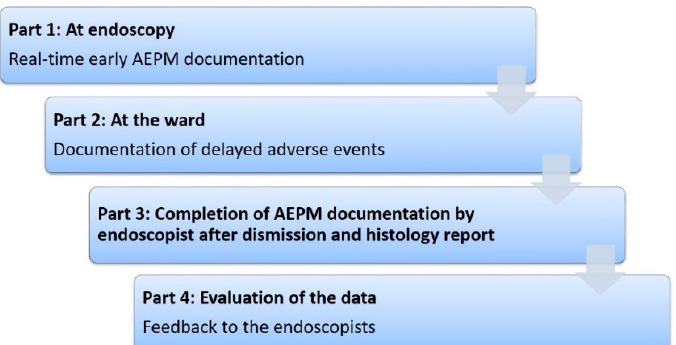
Figure 1. Process flow of AEPM monitoring. The AEPM form is a mandatory part of the endoscopic report and the medical record. It is processed in three steps: at endoscopy, on the ward after discharge of the patient, and, finally, by the endoscopist after evaluation of the patient’s clinical course.